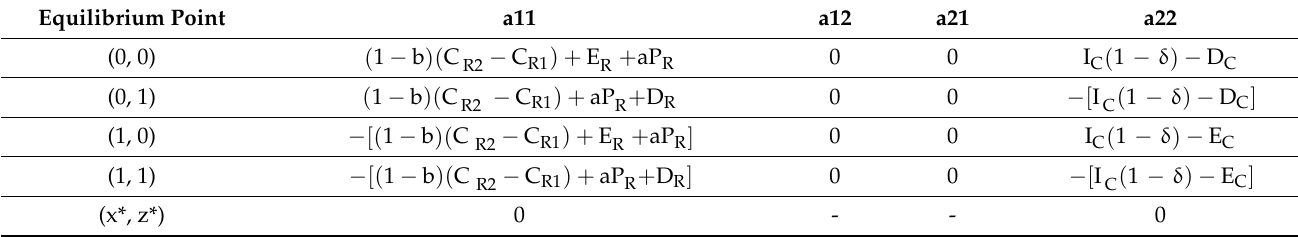
Table 6. The value of each partial equilibrium point.